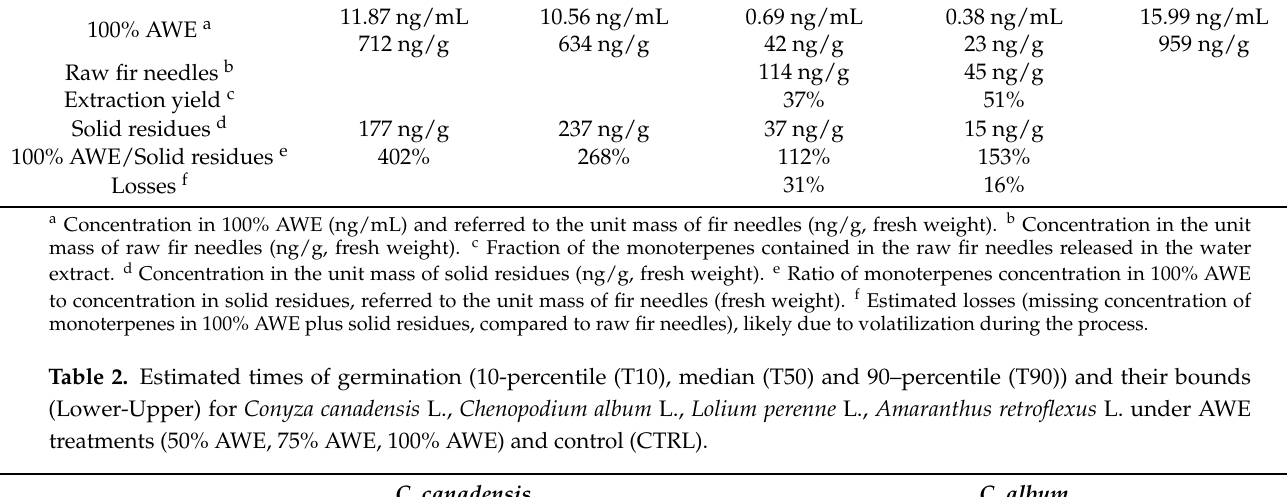
Table 1. Terpene composition of the water extract obtained by hydrodynamic cavitation, raw fir needles and solid residues. α -Pinene Camphene β -Pinene Myrcene Limonene 100% AWE a